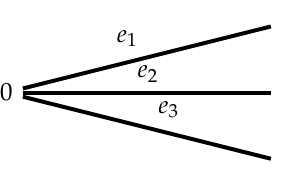
Figure 5. Graph of G ( A )